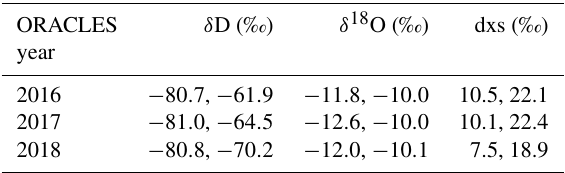
Figure 5. Same as Fig. 4 but for the 2018 sampling period, during which there was a narrower range of q and δ D available for cross calibration compared to 2017. Table 2. Intervals in which 95% of the near-surface (altitude < 500m) WISPER measurements fall after averaging the 1Hz data into 10s blocks, given separately for each ORACLES sampling pe-